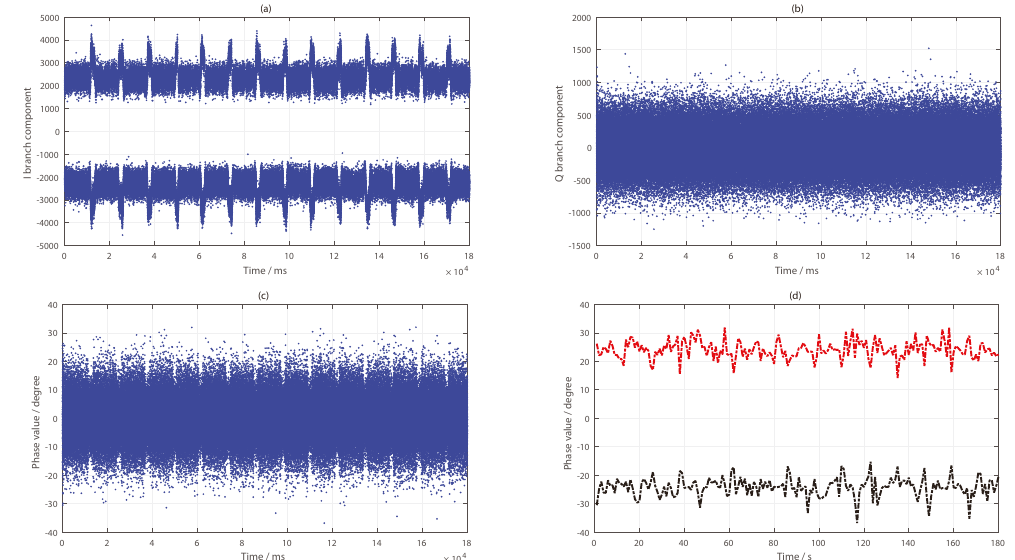
Figure 18. Results for the BeiDou PRN3 satellite reflected signal: ( a ) I branch component data; ( b ) Q branch component data; ( c ) phase difference information (in ms); ( d ) phase difference information (in s).